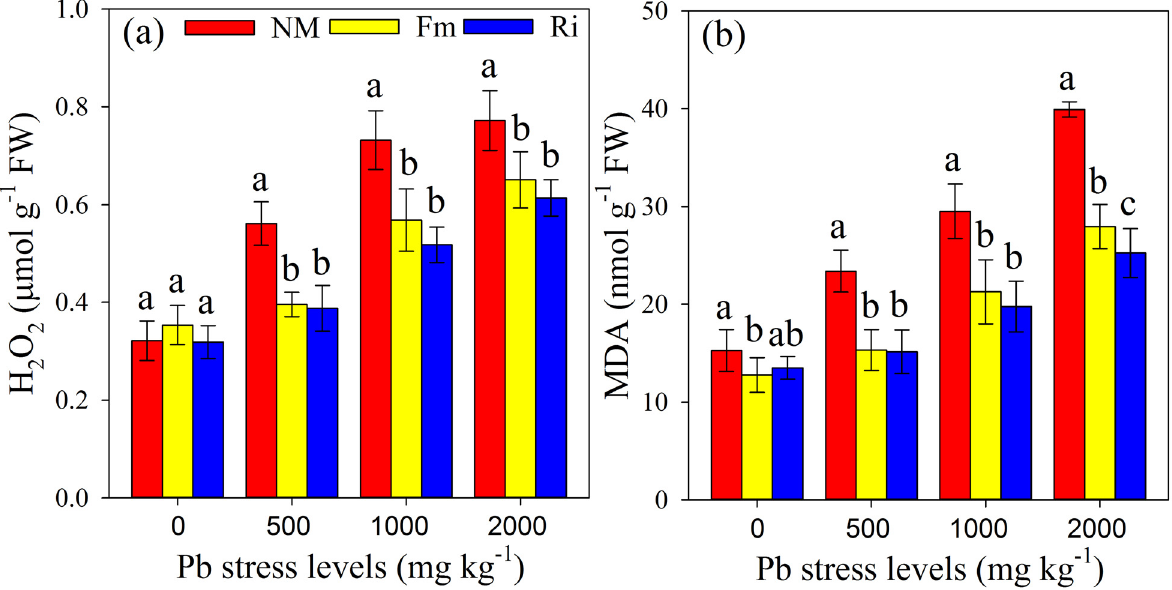
Fig 5. The H 2 O 2 content (a) and MDA content (b) in R . pseudoacacia leaves were affected by Pb stress levels and AMF inoculation. NM, non- inoculated control; Fm, inoculated with F . mosseae ; and Ri, inoculated with R . intraradices . The results are the mean (n = 6) ± SD. The same letter indicates no significant difference among treatments (Duncan ’ s test, P < 0.05). Two-way ANOVAs were used to determine the significance of the effects of the Pb level (Pb), AMF inoculation (AMF), and their interactions (Pb × AMF) on those parameters, as shown in S5